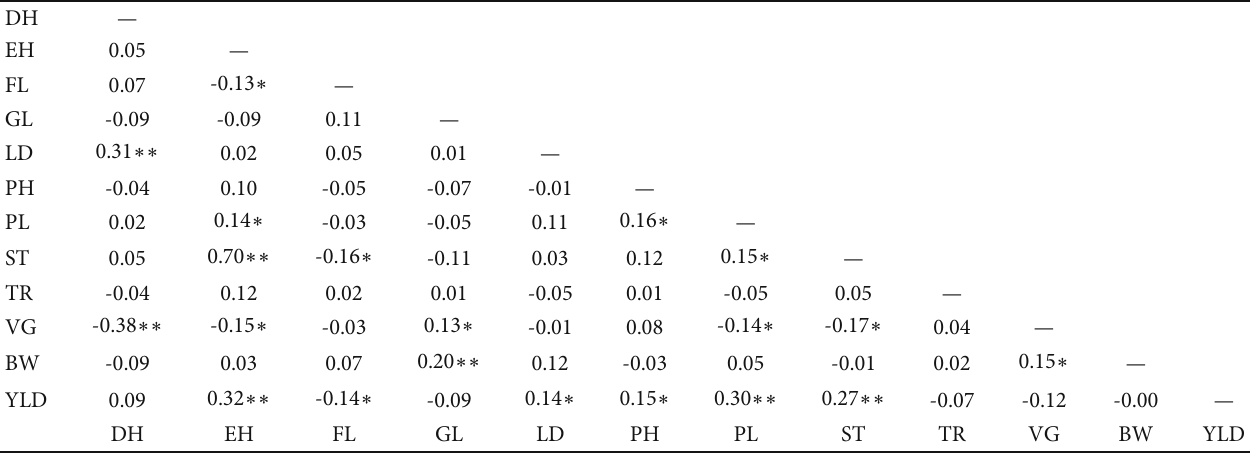
∗ and ∗∗ indicate that data are signi fi cant at the ≤ 0.05 and ≤ 0.01 probability levels, respectively; PH=plant height; DH=deadheart; EH=exit holes; FL=days to fl owering; GL=leaf glossiness; LD=leaf damage; PL=panicle length; ST=stem tunneling; TR=trichome density; VG=seedling vigour; BW=bloom waxiness; YLD=total grain yield. Table 10: Correlation coe ffi cients between B. fusca damage and agro-morphological traits at Kabete site. DH